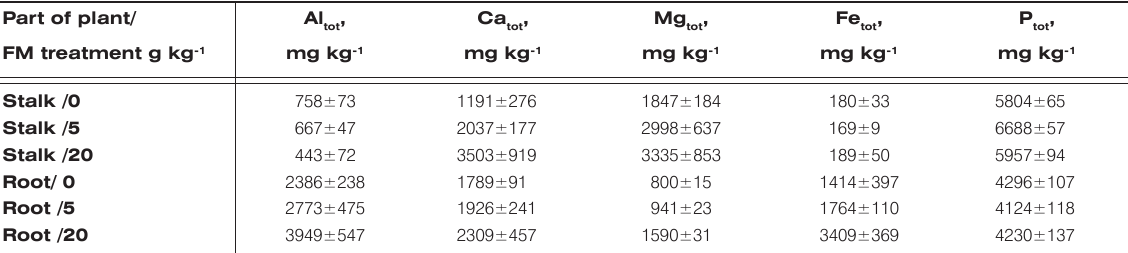
Table 2. Part of plant/ FM treatment g kg